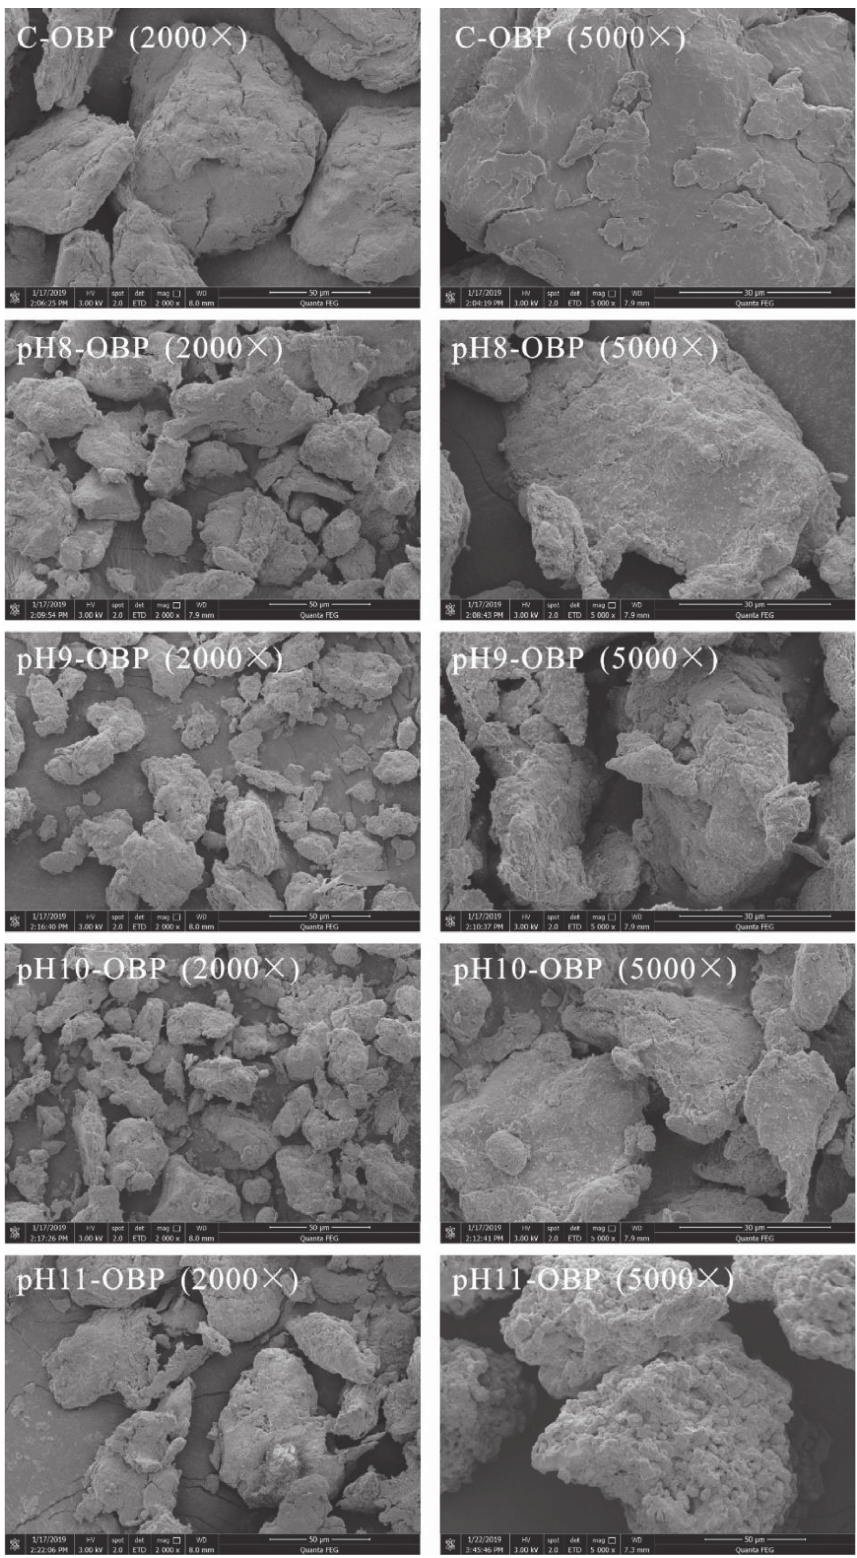
Figure 8: Scanning electron microscopy (SEM) images of oil body interface proteins under different pH conditions (magnification of 2,000x and